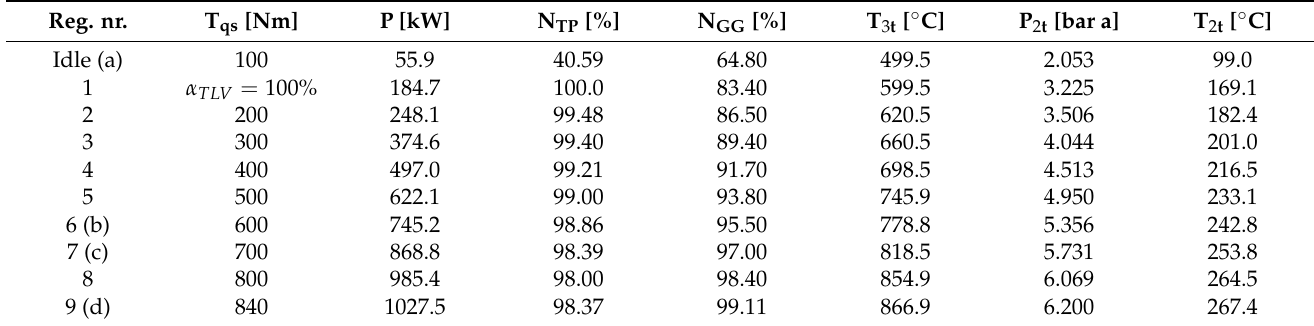
Table 2. Measured parameters at each engine working regime part one.